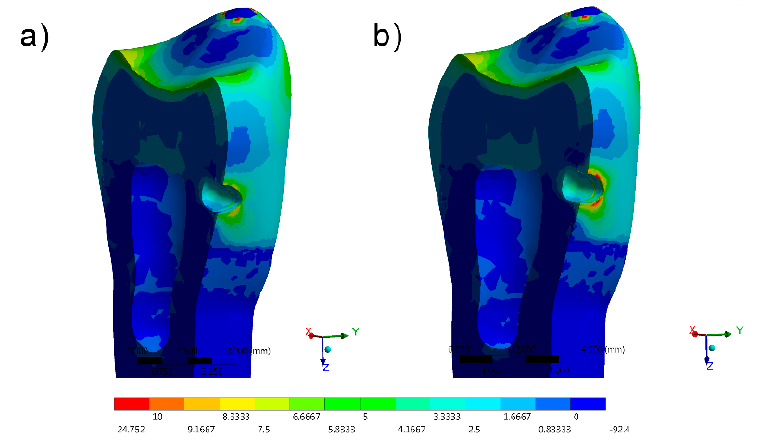
Figure 3. Loading method performed in the present simulation using a stainless steel spherical loading device.